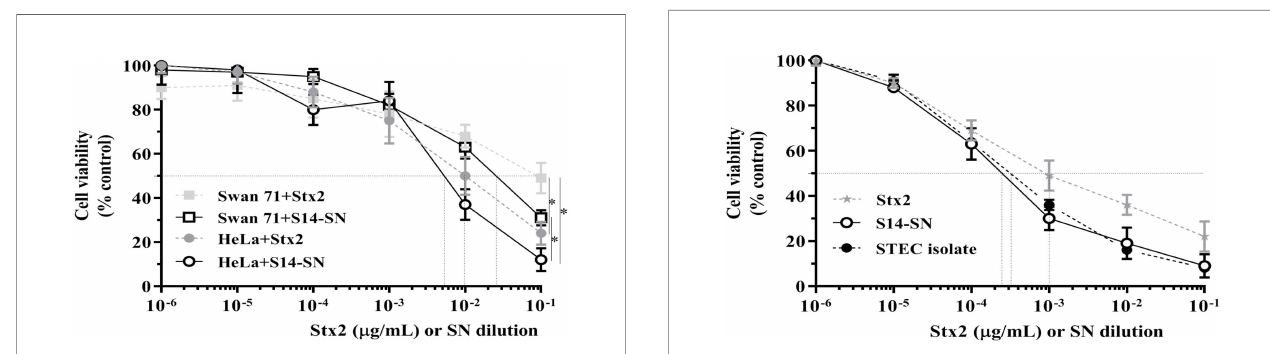
FIGURE 5 | Cytotoxic effects of the STEC isolate O113:NT obtained from an endocervical sample on the viability of Vero cells. Cells were exposed to puri fi ed Stx2 or serial dilutions of supernatants from STEC O113:NT or sample S14 for 72 h. Cell viability was analyzed by neutral red uptake. Data are shown as mean ± S.D from at least three independent experiments performed in triplicate. *p < 0.05 .